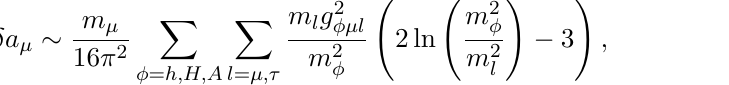
(cid:22) + (cid:22) (cid:0) s !